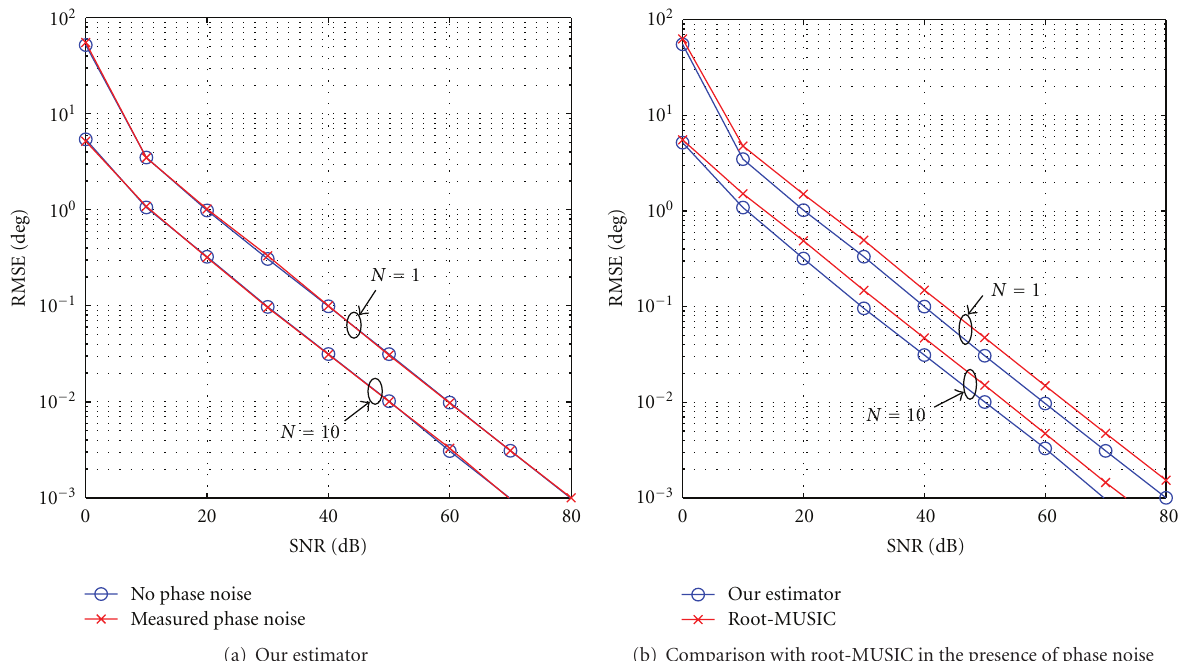
Figure 9: Aggregate RMSE as a function of SNR, N , and the presence or not of phase noise.